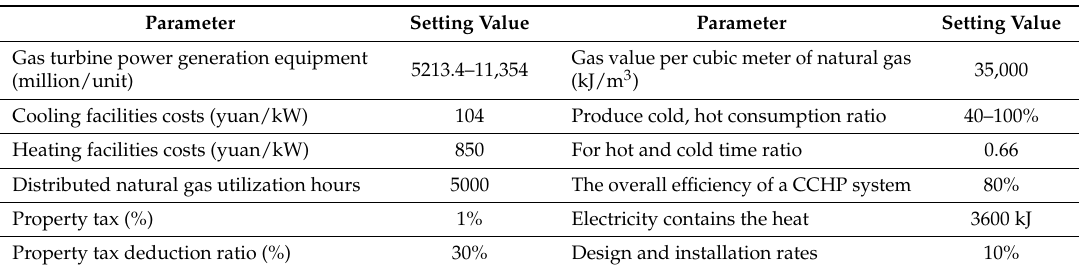
Table 7. Distributed NGPG project related